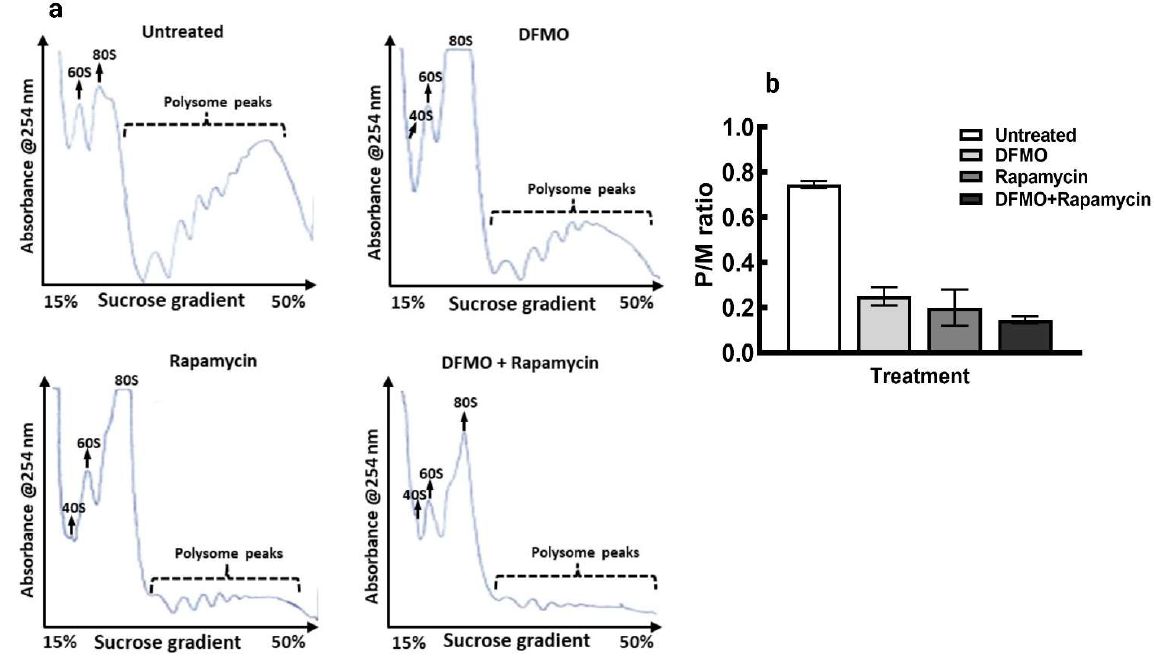
Figure 6. Polysome profile analysis of MCF-7 cells following treatment with DFMO and Rapamycin and the combination of both. Representative of polysome profiles of cells grown for 72 h with no treatment (top left), cells grown for 24 h followed by 5mM DFMO treatment for 48 h (top right), cells grown for 24 h followed by treatment with 0.1 µM ra- pamycin for 48 h (bottom left), and cells grown for 24 h followed by 5 mM DFMO plus 0.1 µM rapamycin treatment for 48 h (bottom right). Cells were harvested and processed for polysome analysis, ( a ) Images for each treatment shown is a representation for two independent experiments. ( b ) Estimation of polysome to monosome ratio from (a). Values shown are mean ± range for two independent experiments for all treatments.